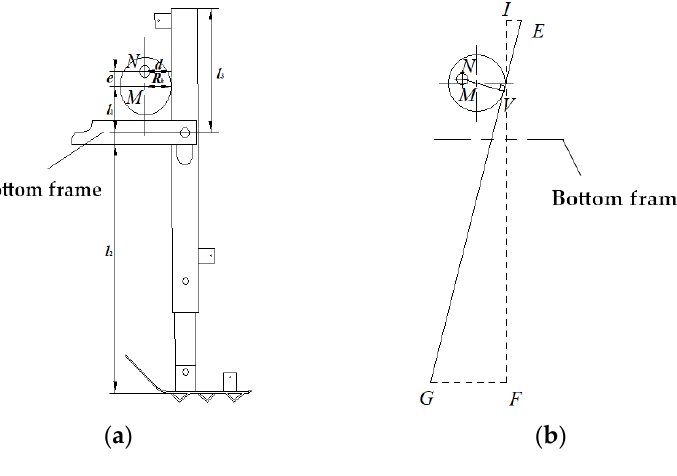
Figure 6. Movement state diagram of the weeding shovel: ( a ) vertical state, ( b ) forward swing state, ( c ) backward swing state. N is the center of eccentric wheel hub; M is the center of the eccentric contour; I and F are the two vertex positions of the swing rod in the vertical state; E and G are the two vertex positions of the swing rod when the swing rod swings forward to the farthest distance; H and J are the positions of the two vertices of the swing rod when the swing rod swings back to the farthest distance; V and T are the contact points between the eccentric wheel and the support bar when the swing rod swings forward and backward; EG and HJ are the straight lines in which the swing rod swings forward and backward; d is the distance from the center of the eccentric wheel hub to the swing rod when the weeding shovel is vertical; R k is the contour radius of the eccentric wheel; e is the eccentricity of eccentric wheel; l 1 is the distance from the center of the eccentric wheel hub to the bottom frame; l 2 is the distance from the bottom frame to the ground; l 3 is the distance between the bottom frame and the top